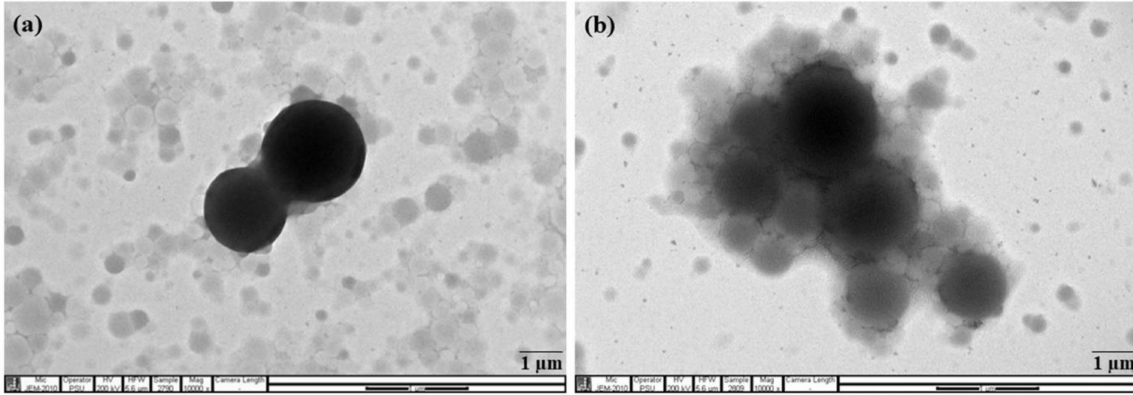
Figure 9. Transmission electron micrographs of ( a ) Fresh natural latex; and ( b ) Cream concentrated latex from the RRIM600 clones. ( ×